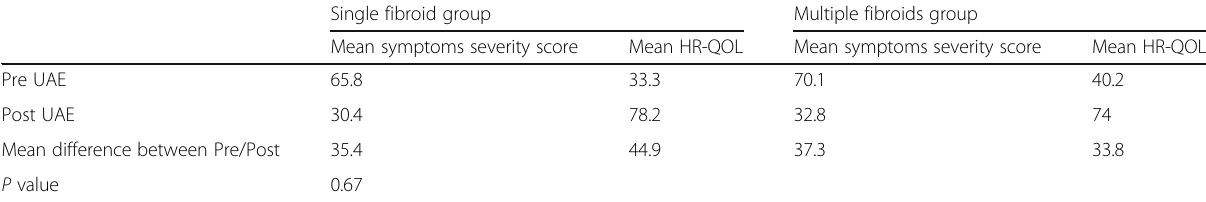
Table 4 Mean symptom severity score and mean HR QOL